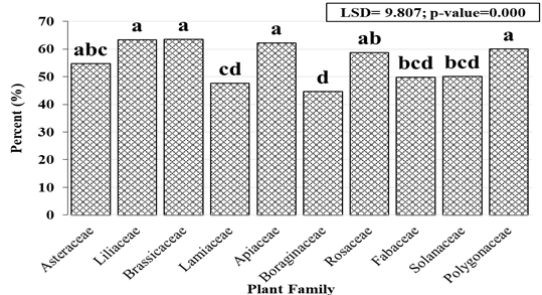
Fig. 9. Antioxidant capacity of plant families regardless of plant species using ABTS method.